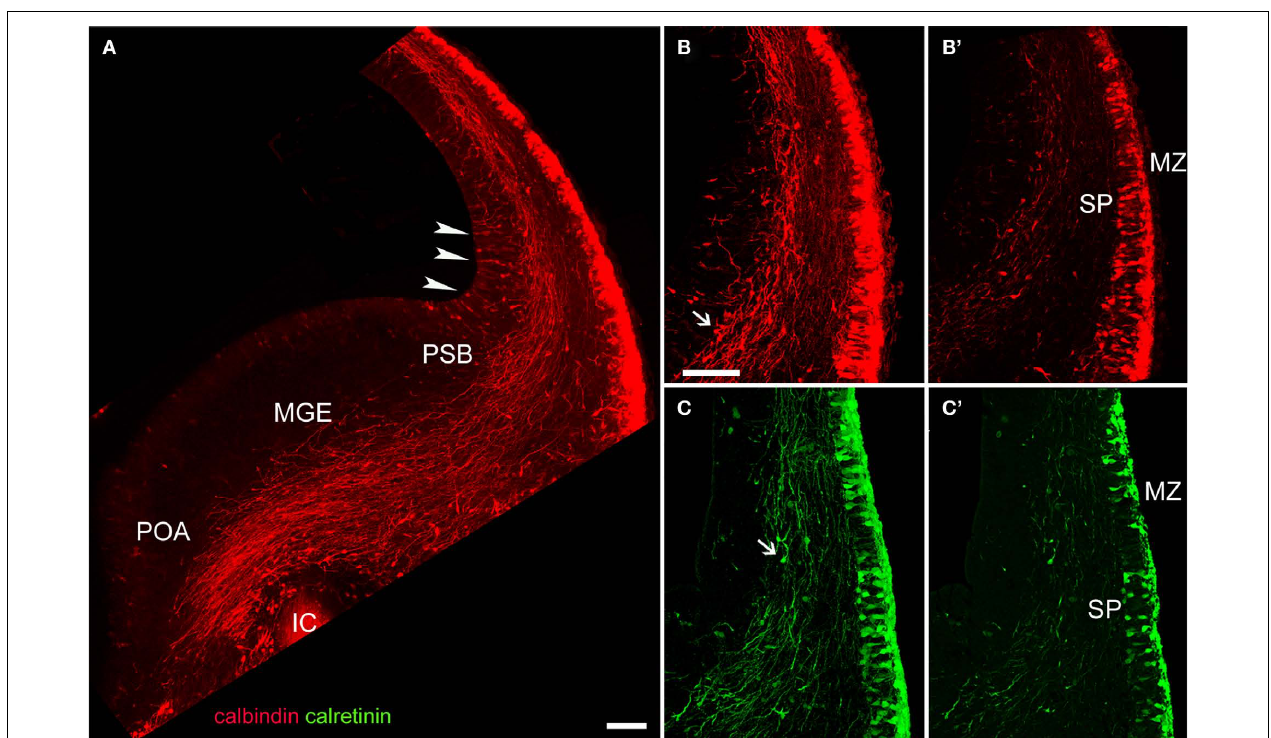
FIGURE 3 | CB and CR immunostaining of a corticofugal projection in E15.5 rats. (A) The dense corticofugal CB projection from the preplate avoided entering the posterior limb of the internal capsule (IC). Arrowheads indicate CB + cells in the cortical VZ, near the pallial-subpallial boundary (PSB). (B–C ′ ) CR + cells were less abundant in subplate than CB cells. Note in (B) and (C) immunostained axons in